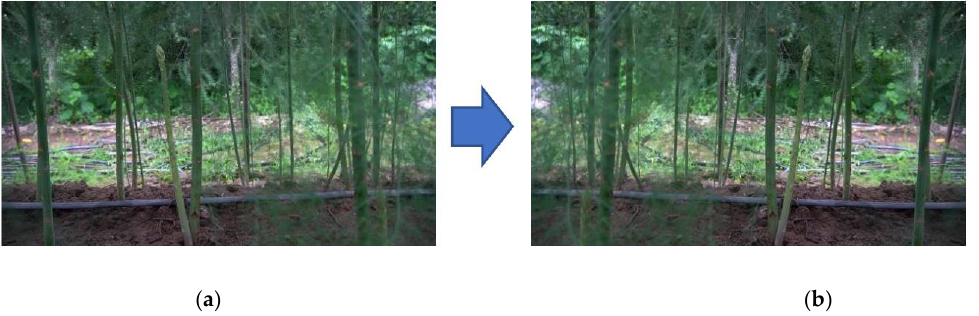
Figure 4. Photo after image enhancement. ( a ) Original photo; ( b ) photo after being flipped horizontally.